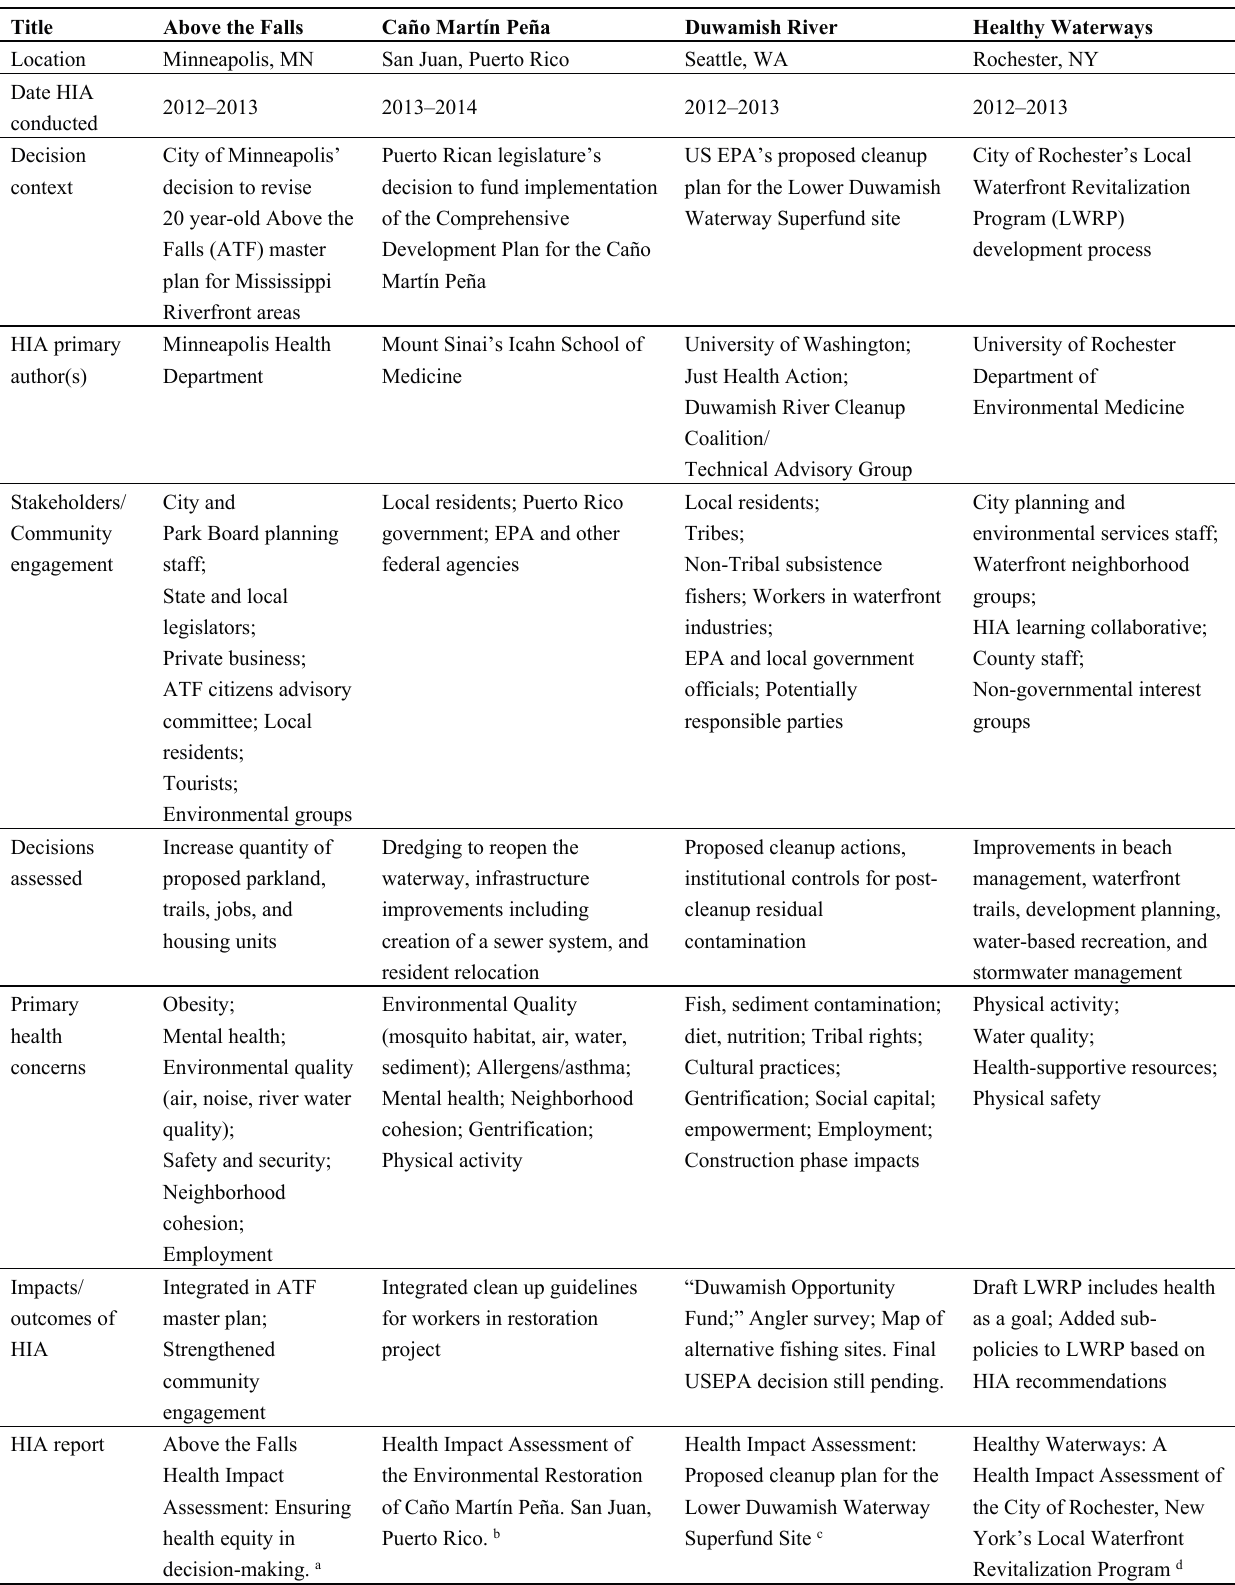
Table 1. Four waterway Health Impact